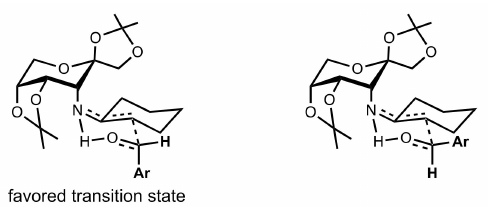
Figure 37. The proposed transition state of the aldol reaction catalysed by 516